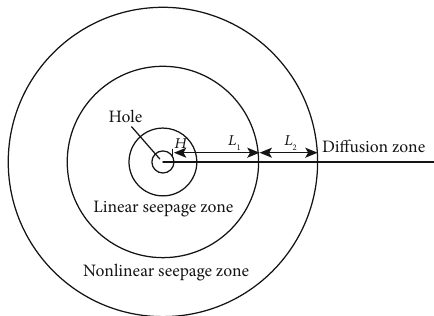
1 and L 2 are the maximum distance for